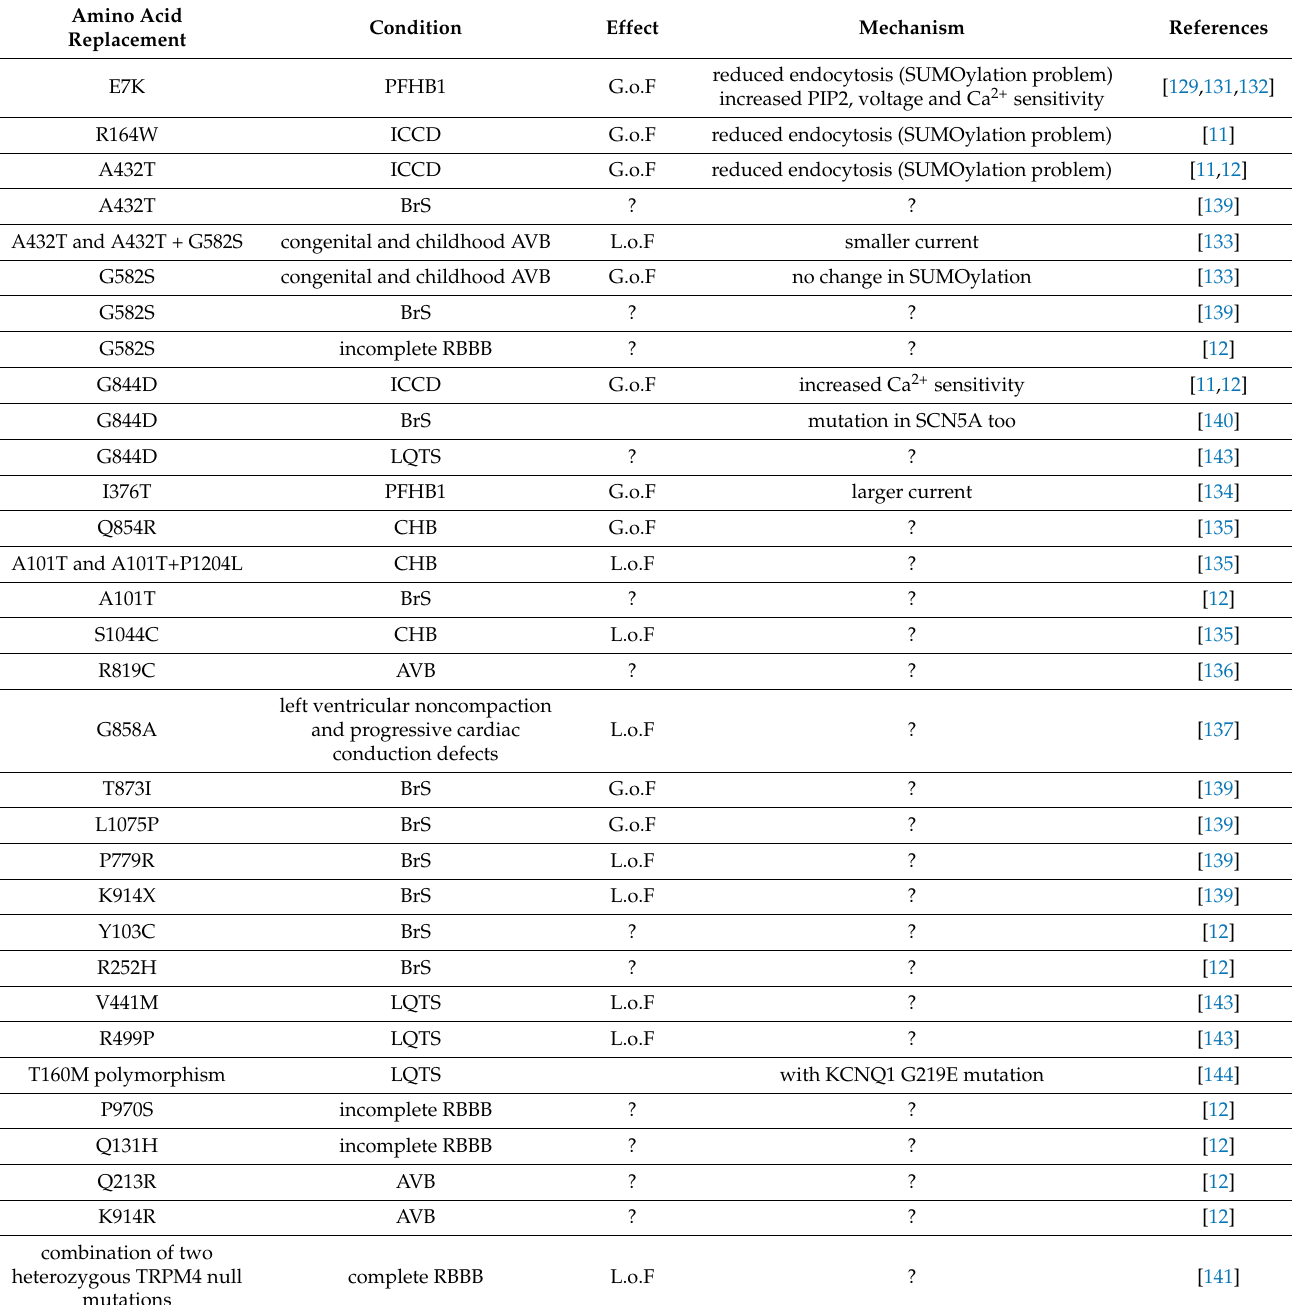
Table 3. TRPM4 mutations involved in cardiac conduction